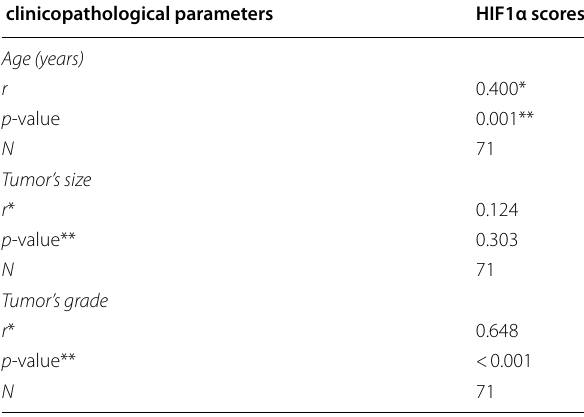
Table 3 Correlation between HIF1α expression scores with age, tumor size and